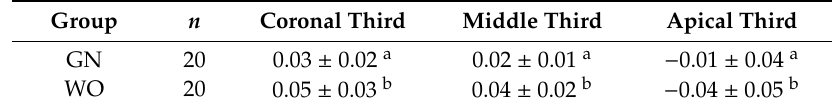
Table 2. The magnitude of transportation of mesial root canals after shaping with tested instruments (mm ± SD). Group n Coronal Third Middle Third Apical Third GN 20 0.03 ± 0.02 a 0.02 ± 0.01 a − 0.01 ± 0.04 a WO 20 0.05 ± 0.03 b 0.04 ± 0.02 b − 0.04 ± 0.05 b